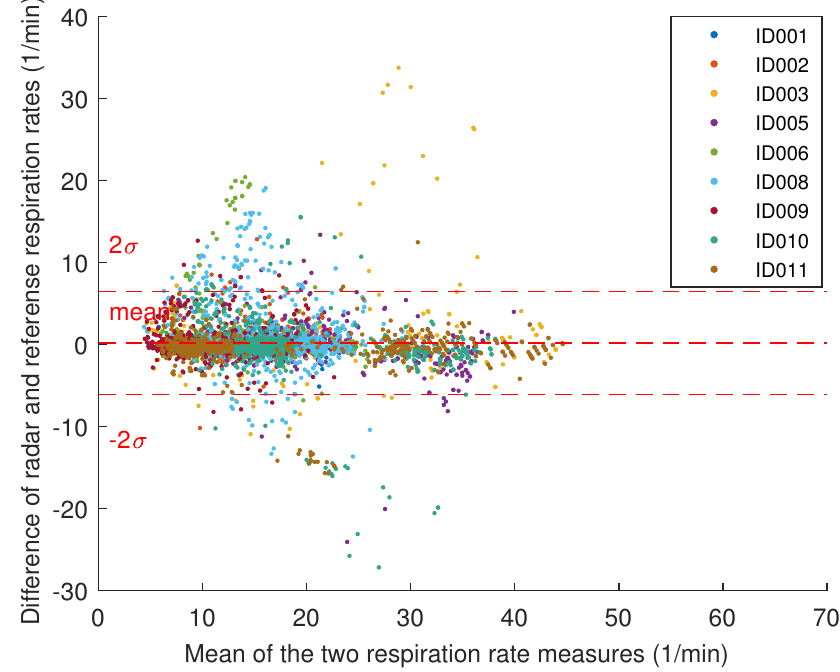
Figure 9. The Bland-Altman plot for respiration rate. The dashed lines indicate the mean and the interval containing 95% of the